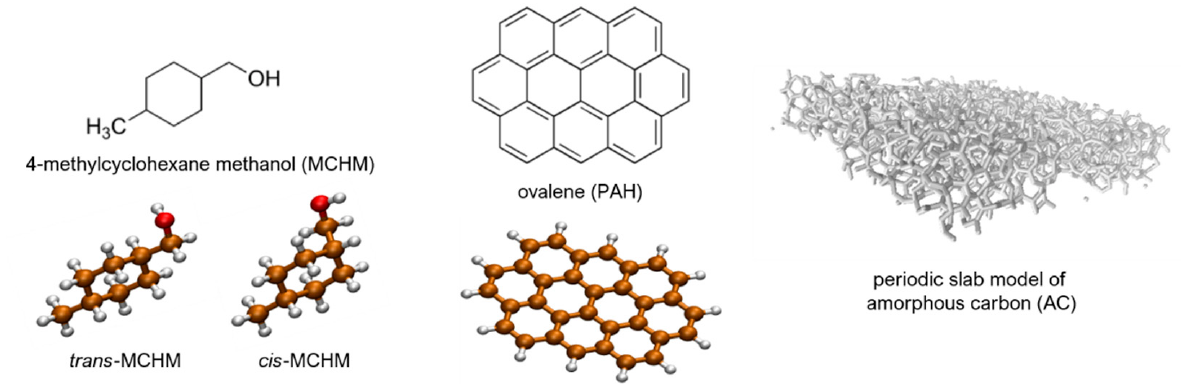
Figure 4. Structures used in this study.